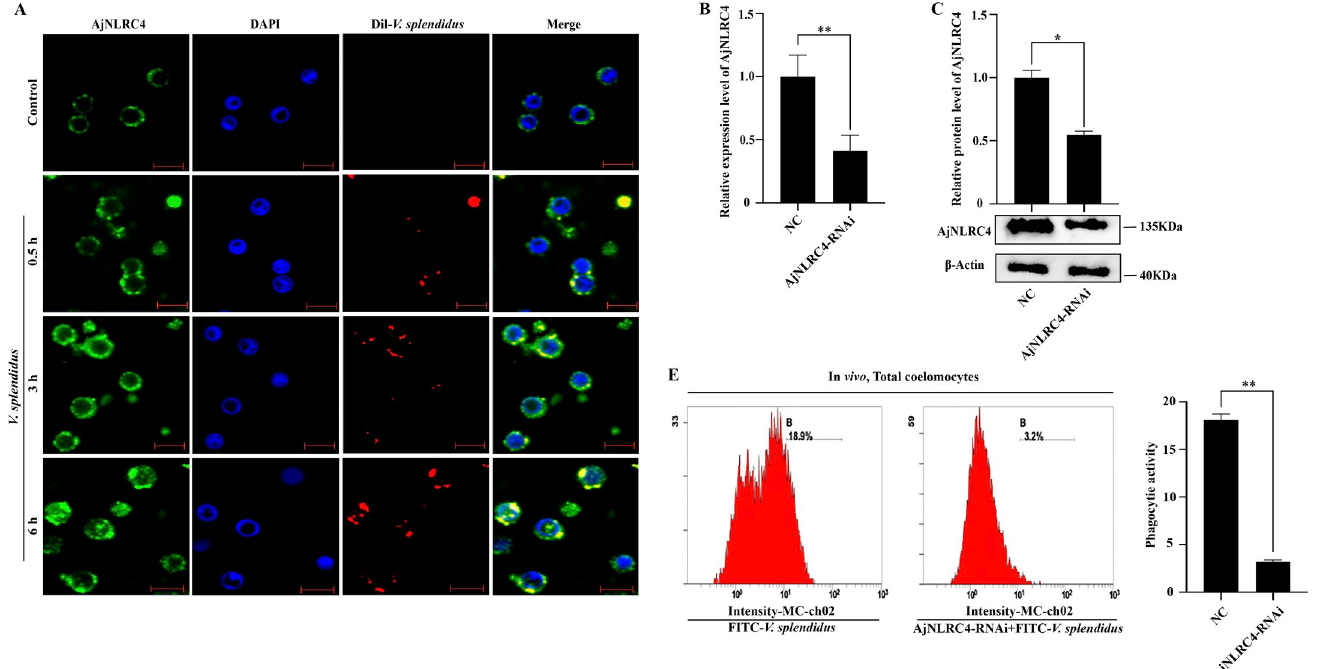
Fig 4. AjNLRC4 acts as a receptor of V . splendidus and mediates its endocytosis. (A) Immunocytochemistry was used to detect the colocalization of AjNLRC4 and Dil-labeled V . splendidus in coelomocytes. The coelomocytes were collected at different time points (0.5, 3, and 6 h) post- V . splendidus injection. Scale bar = 5 μ m. The graphs are representative of three independent assays, and the proportions were calculated from those three assays, � p < 0.05. (B-C) The efficiency of AjNLRC4-RNAi in coelomocytes was determined using qPCR and western blotting analysis. The graphs are representative of three independent assays, and the proportions were calculated from those three assays, � p < 0.05, �� p < 0.01. (D) Flow cytometry was performed after knockdown of AjNLRC4 to investigate the phagocytic activity of coelomocytes against V . splendidus . The graphs are representative of three independent assays, and the phagocytic activity was calculated from those three independent assays, �� p <